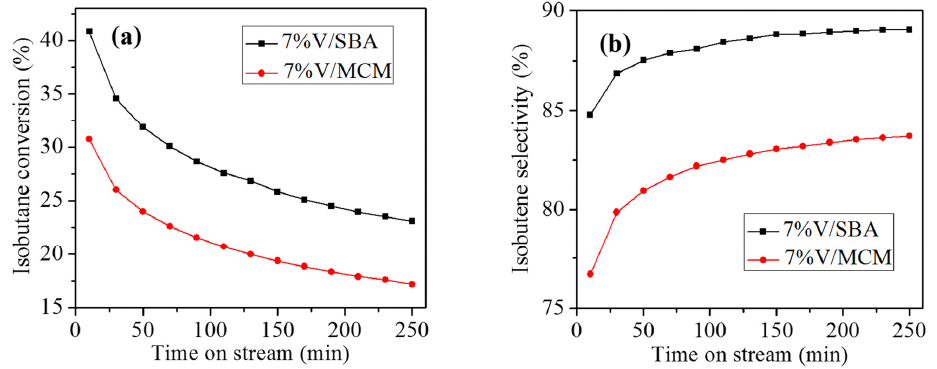
Figure 9. Conversion of isobutane ( a ) and selectivity to isobutene ( b ) as a function of time on stream for 7% V/SBA and 7% V/MCM catalysts at 570 °C.